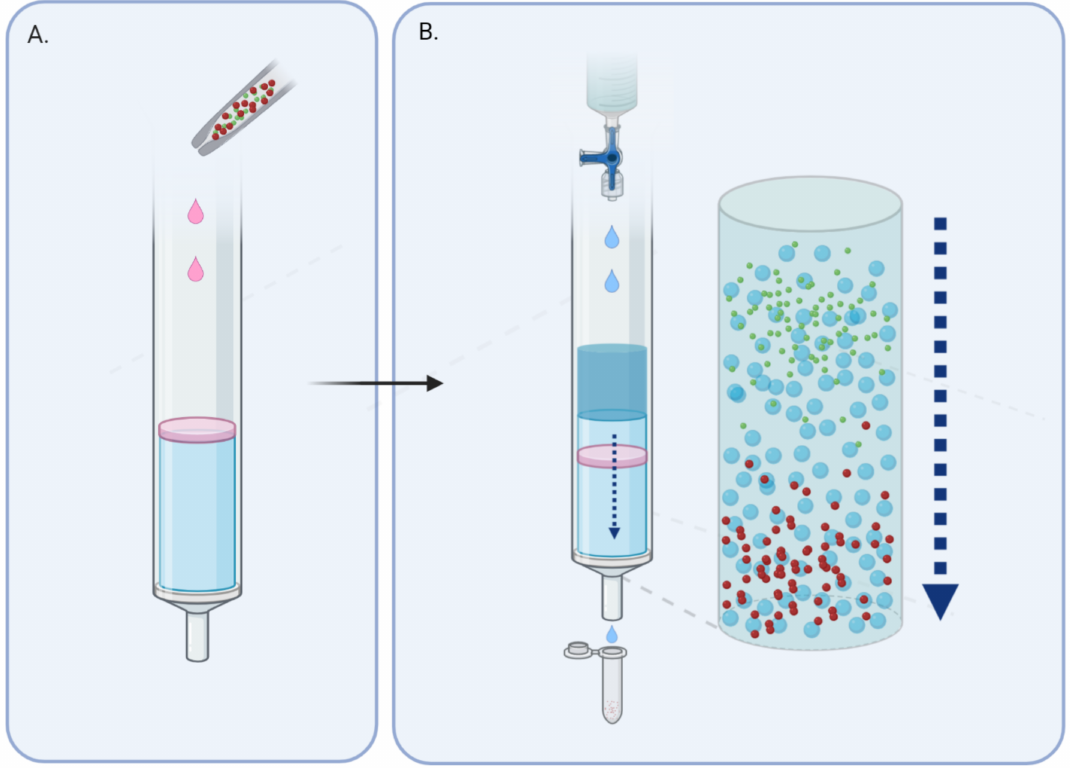
Figure 1. Larger particles take a more direct path through the gel and elute first. ( A ) Sample is layered onto column prepared with gel matrix. ( B ) With continuous addition of wash bu ff er, separation of the sample according to size occurs along the